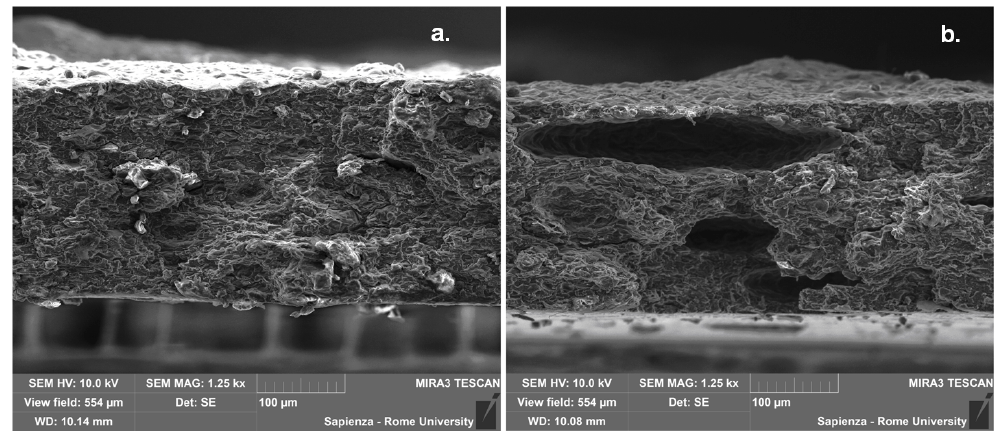
Figure 8. Fracture surface of the composite, without ( a ) and with ( b ) pulled-out leather particles at failure.